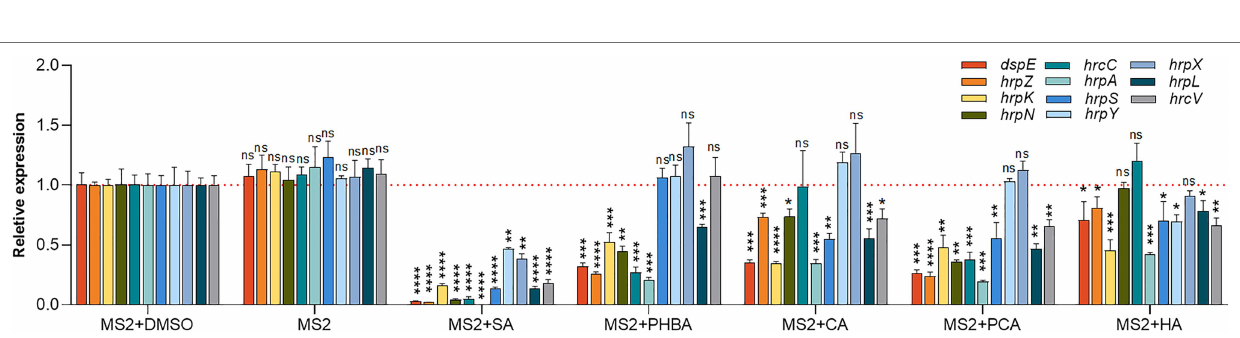
of three replicates and subjected to Student’s t -test analysis by Graphpad Prism 8.4.3 (ns, no statistical significance, ** p < 0.01, **** p <